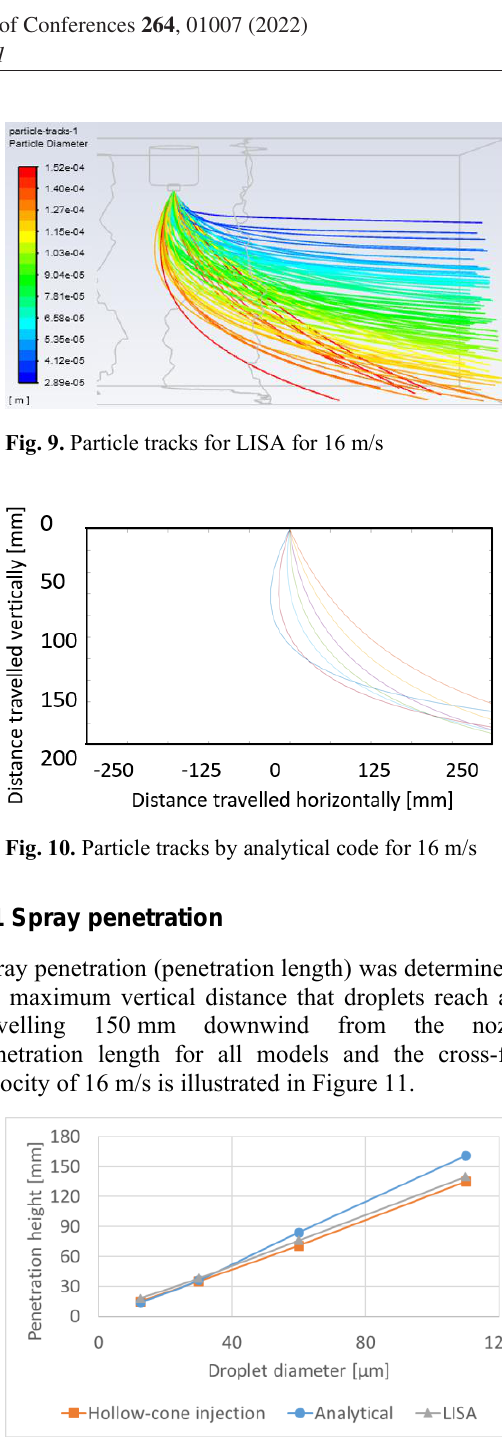
Fig. 11 Penetration length determined by different models for cross-flow velocity of 16 m/s